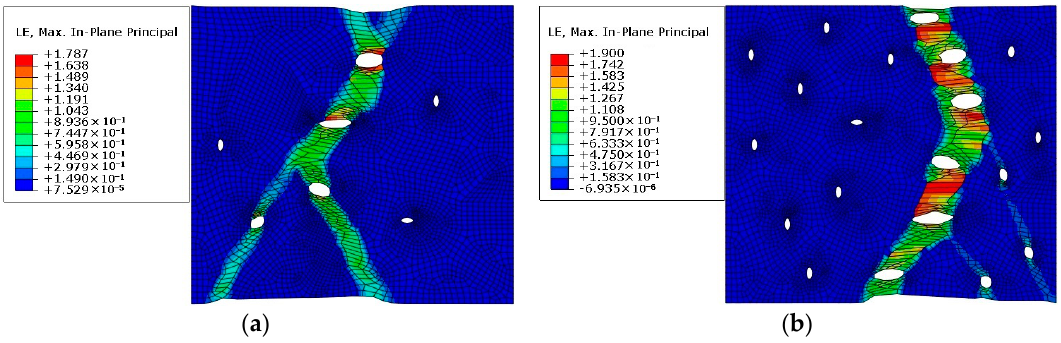
Figure 18. Tensile strain diagram with porosity of ( a ) 0.4% and ( b ) 1.3%.